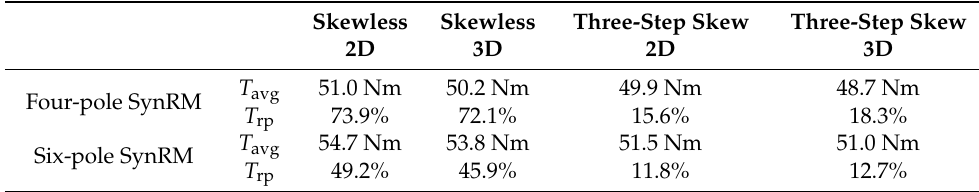
Table 6. Average torque and torque ripple comparison when applying three-step skewing, by means of 2D and 3D FEA simulations.